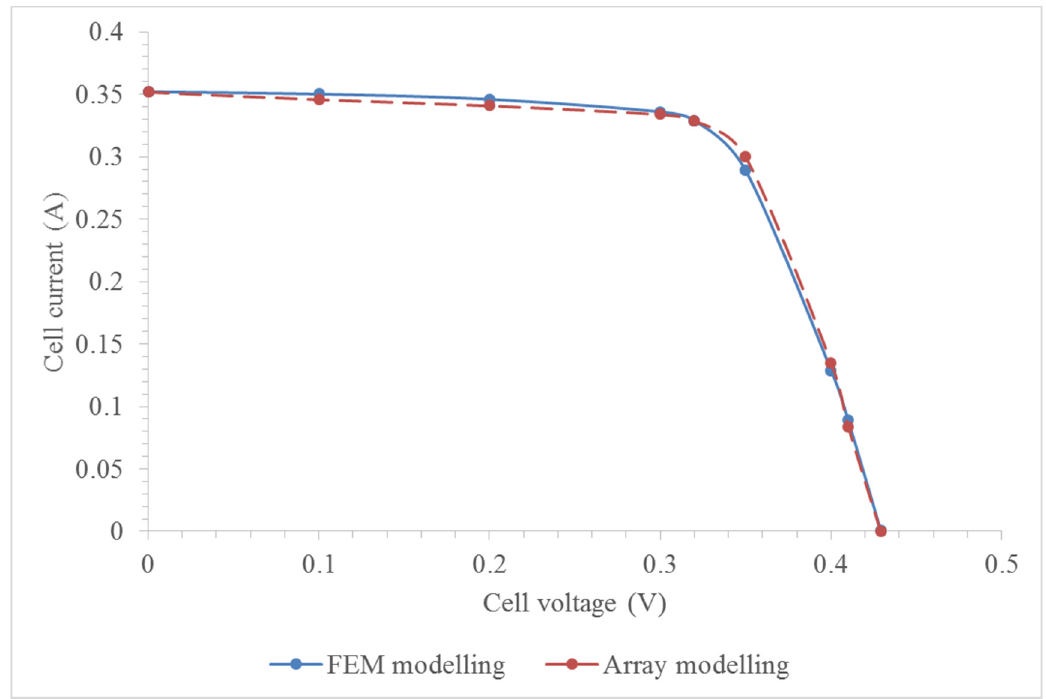
Figure 14. I-V curves given by array modelling and FEM modelling for illumination Profile